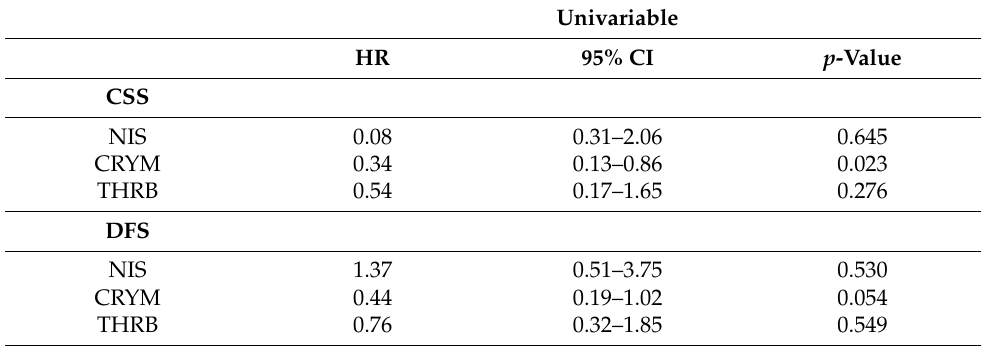
Table 2. Univariable analysis of CSS and DFS and protein levels of NIS, CRYM, and